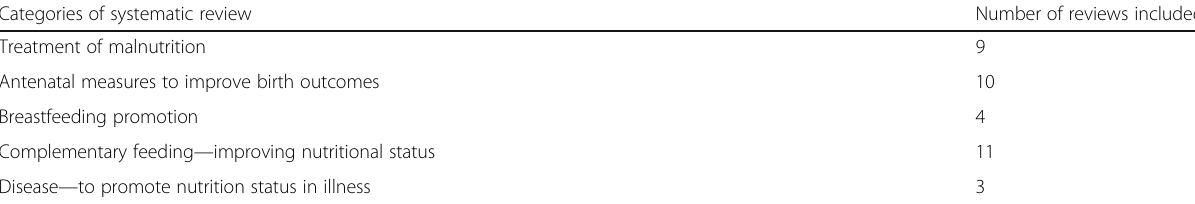
Table 1 Categories of systematic reviews in the Evidence Aid collection Categories of systematic review Treatment of malnutrition Antenatal measures to improve birth outcomes Breastfeeding promotion Complementary feeding — improving nutritional status Disease — to promote nutrition status in